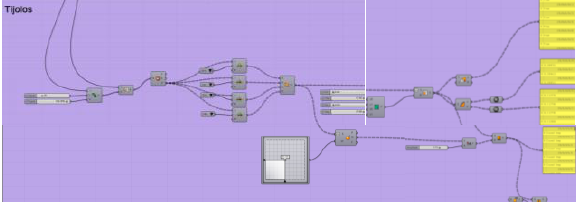
Figure 14: Grasshopper © script created to verify the